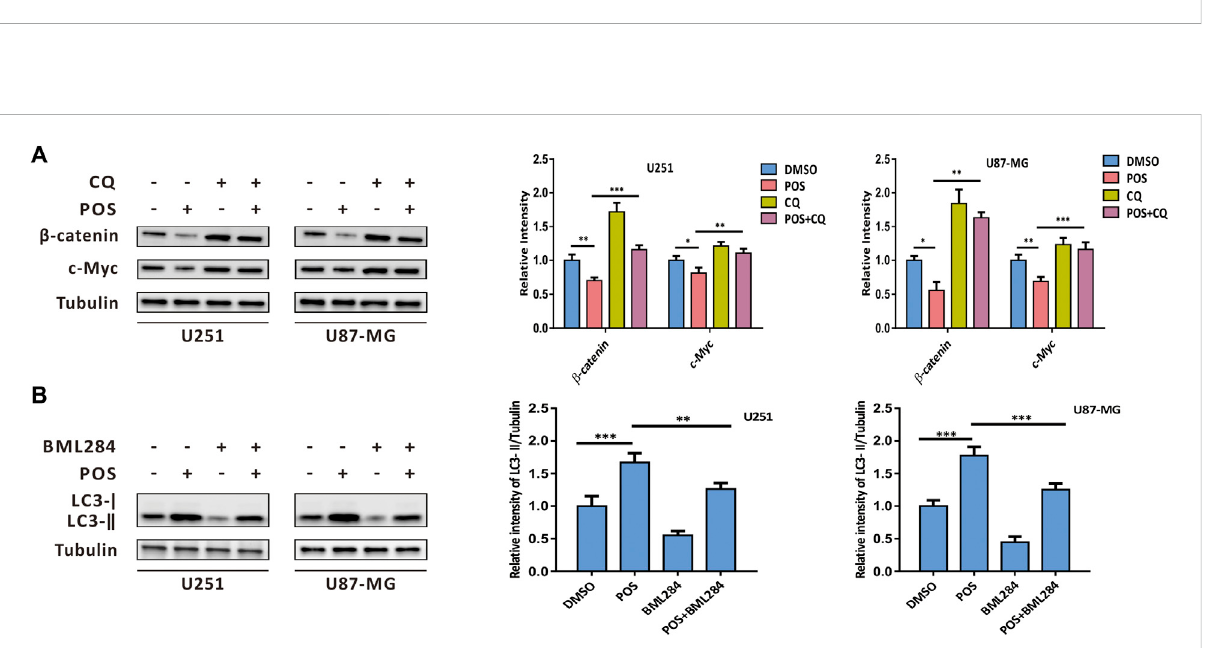
FIGURE 6 POS attenuates CSCs stemness via the Wnt/ β -catenin signaling axis in GBM cells. (A) Expression levels of Wnt1, β -catenin and c-Myc were detected by western blotting after the cells were treated as indicated for 24 h. (B) Self-renewal capacity was detected by a sphere formation assay after the β -catenin-overexpressed or vector control cells were treated with POS or DMSO for 2 weeks. Scale bar, 50 μ M.